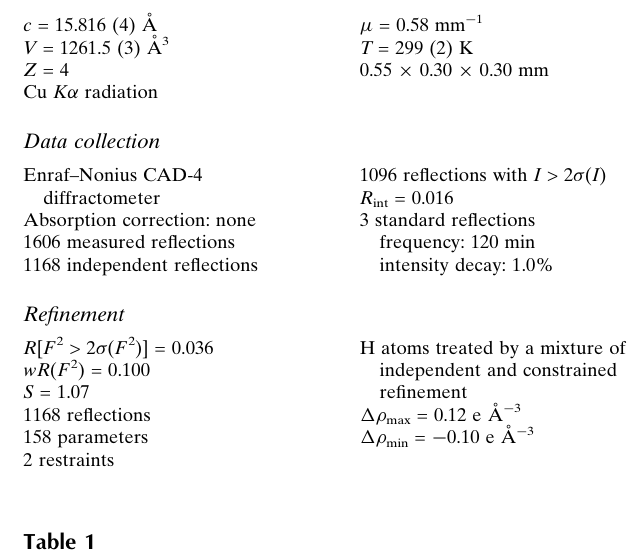
Hydrogen-bond geometry (A˚ , (cid:1)